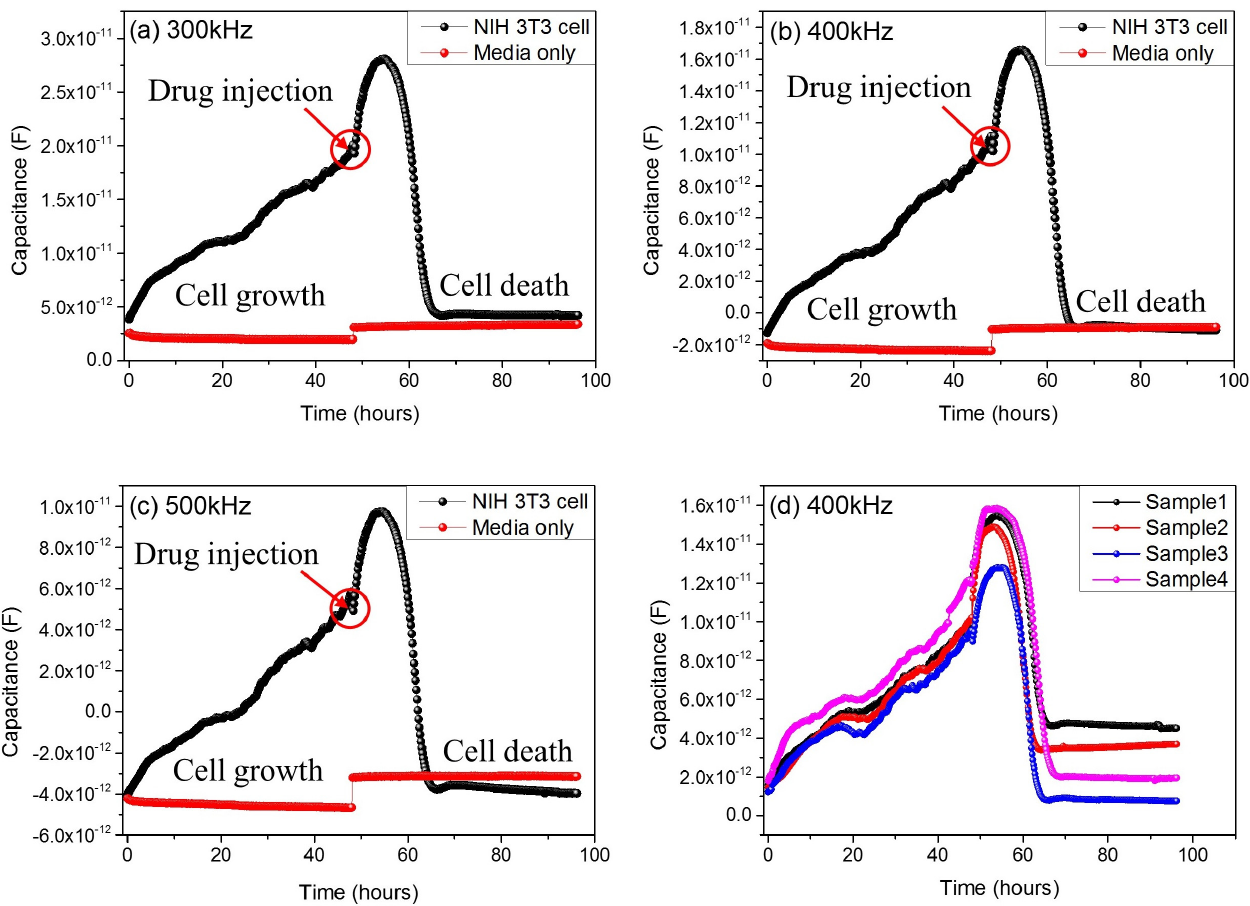
Figure 4. The graph of capacitance to time flow in sensitive frequency band (300 kHz ( a ), 400 kHz ( b ), 500 kHz ( c )) and multiple plots of four different samples at 400 kHz for the reproducibility confirmation ( d ).